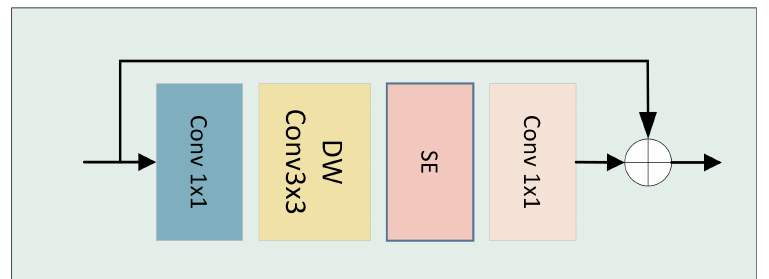
Figure 5. The MV2